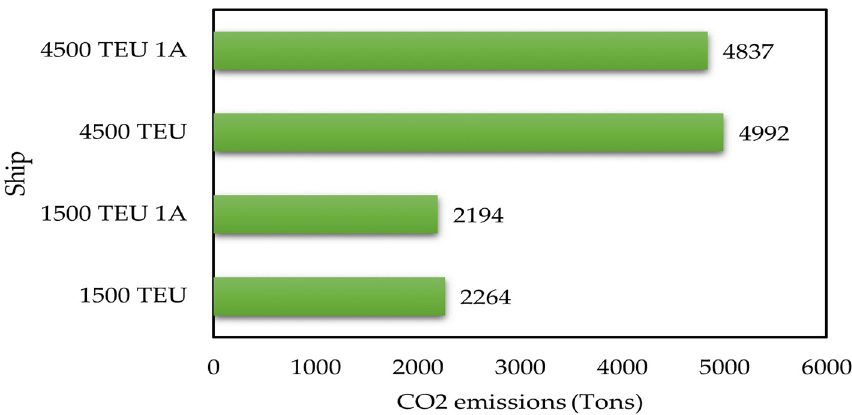
Figure 4. Comparison of CO 2 emissions for Europe sea route and Northeast Passage.